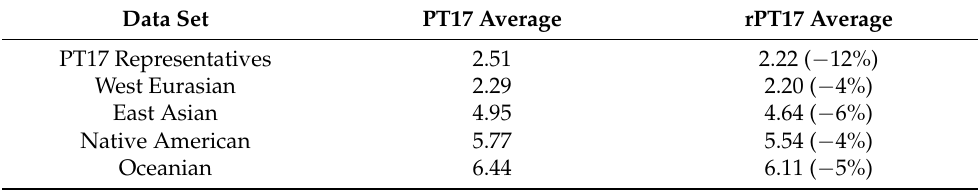
Table 1. Average number of essential private mutations for full